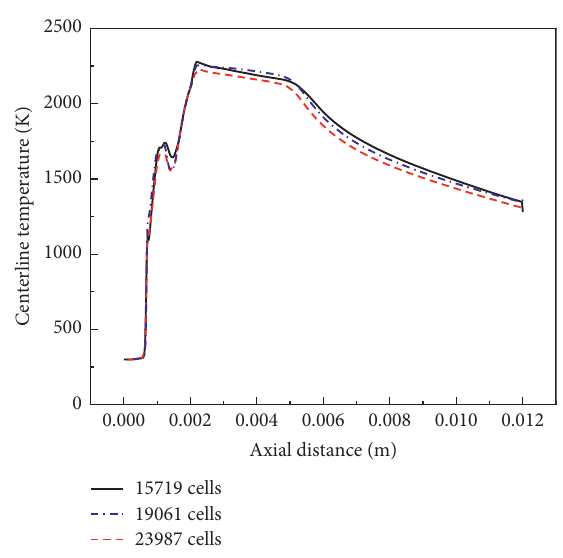
Figure 4: Axial temperature profile of simulation.